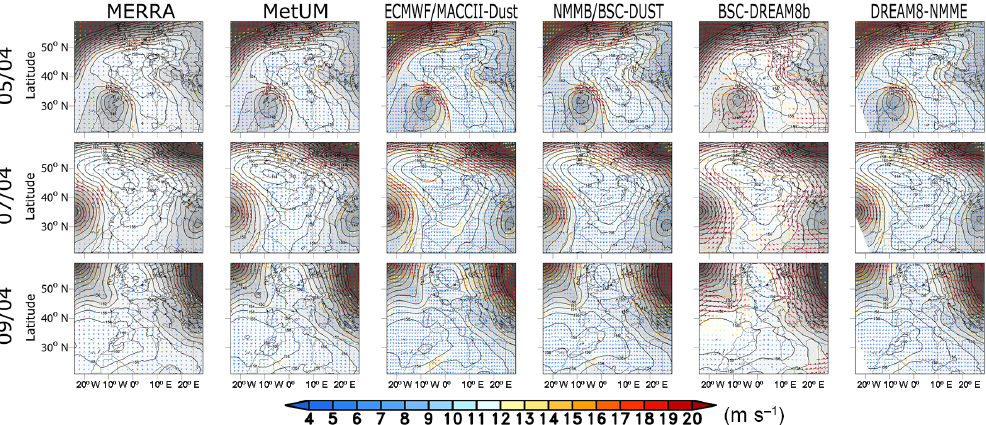
Figure 8. The geopotential height (grey shaded with contour labels in gpdm (geopotential decametre)) and wind speed stream lines at 850hPa on 5 April (first row), 7 April (second row) and 9 April (third row) 2011 at 12:00UTC from MERRA reanalysis and the 24h forecasts from MetUM, ECMWF/MACC, NMMB/BSC-DUST, BSC-DREAM8b and DREAM8-NMME (from left to